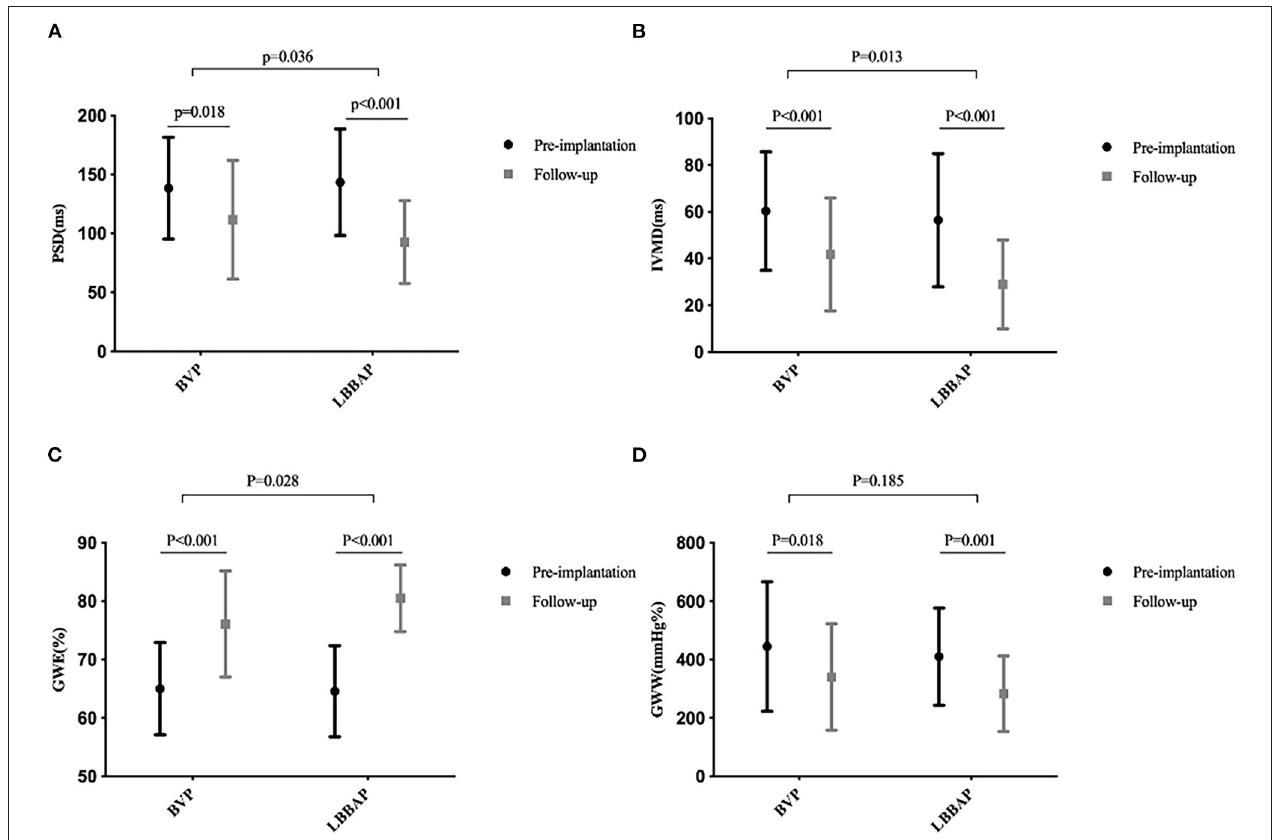
FIGURE 2 | Mechanical synchronization at baseline and follow-up in the BVP and LBBAP groups. (A) Peak strain dispersion (PSD) from baseline to follow-up; (B) interventricular mechanical delay (IVMD) from baseline to follow-up; (C) global work efficiency (GWE) from baseline to follow-up; (D) global wasted work (GWW) from baseline to